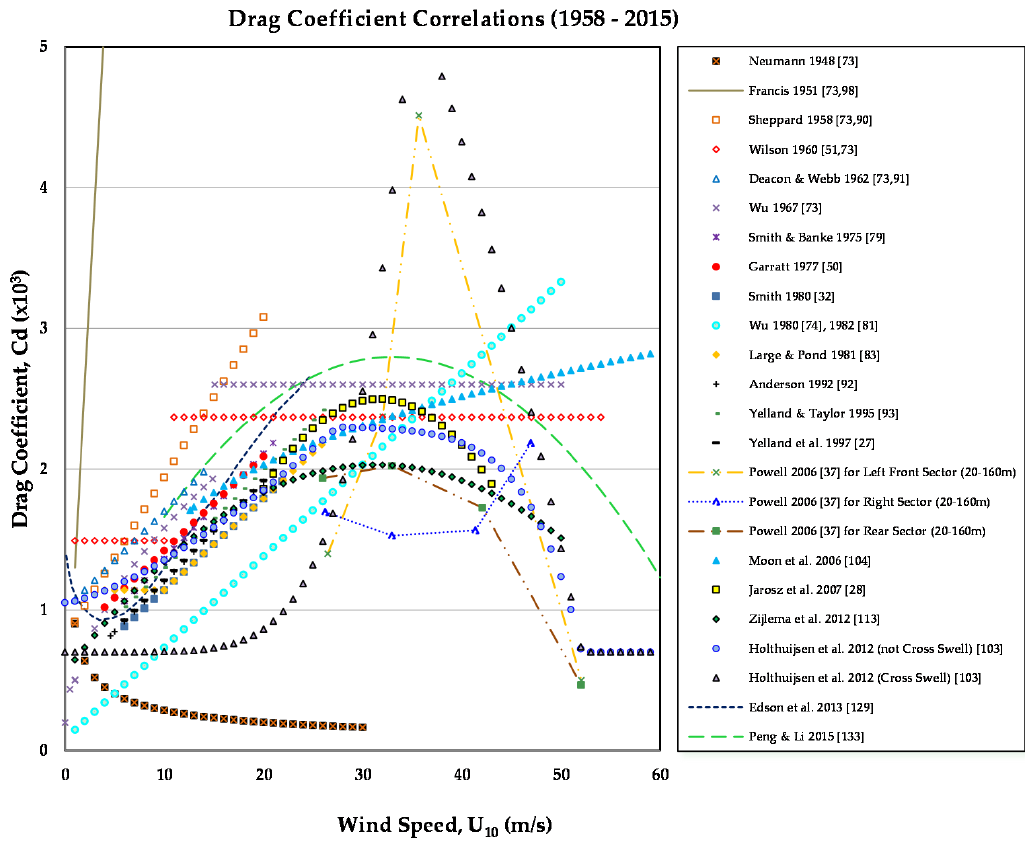
Figure 2. Drag Coefficient Correlations (1958–2015).